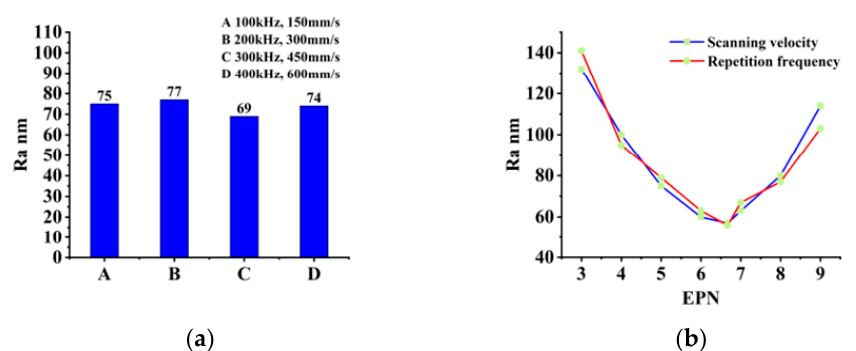
Figure 9. Curve of surface roughness with the change of different polishing parameters: ( a ) Same EPN with different repetition frequency and scanning velocity; ( b ) Different EPN